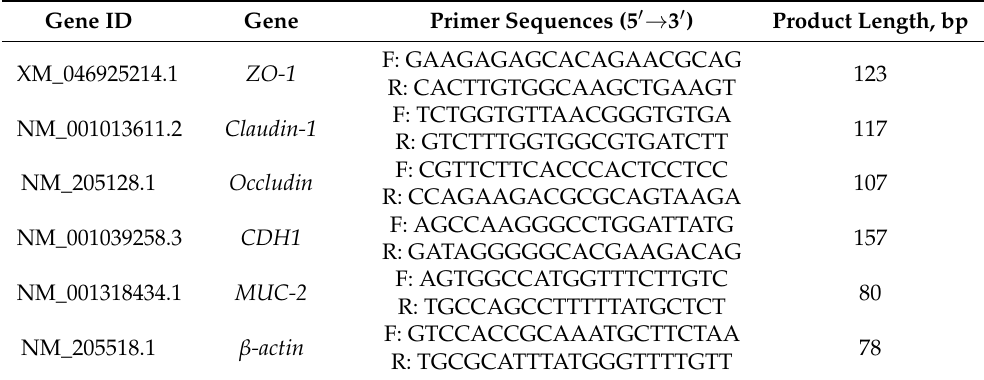
Table 2. The primers for quantitative real-time